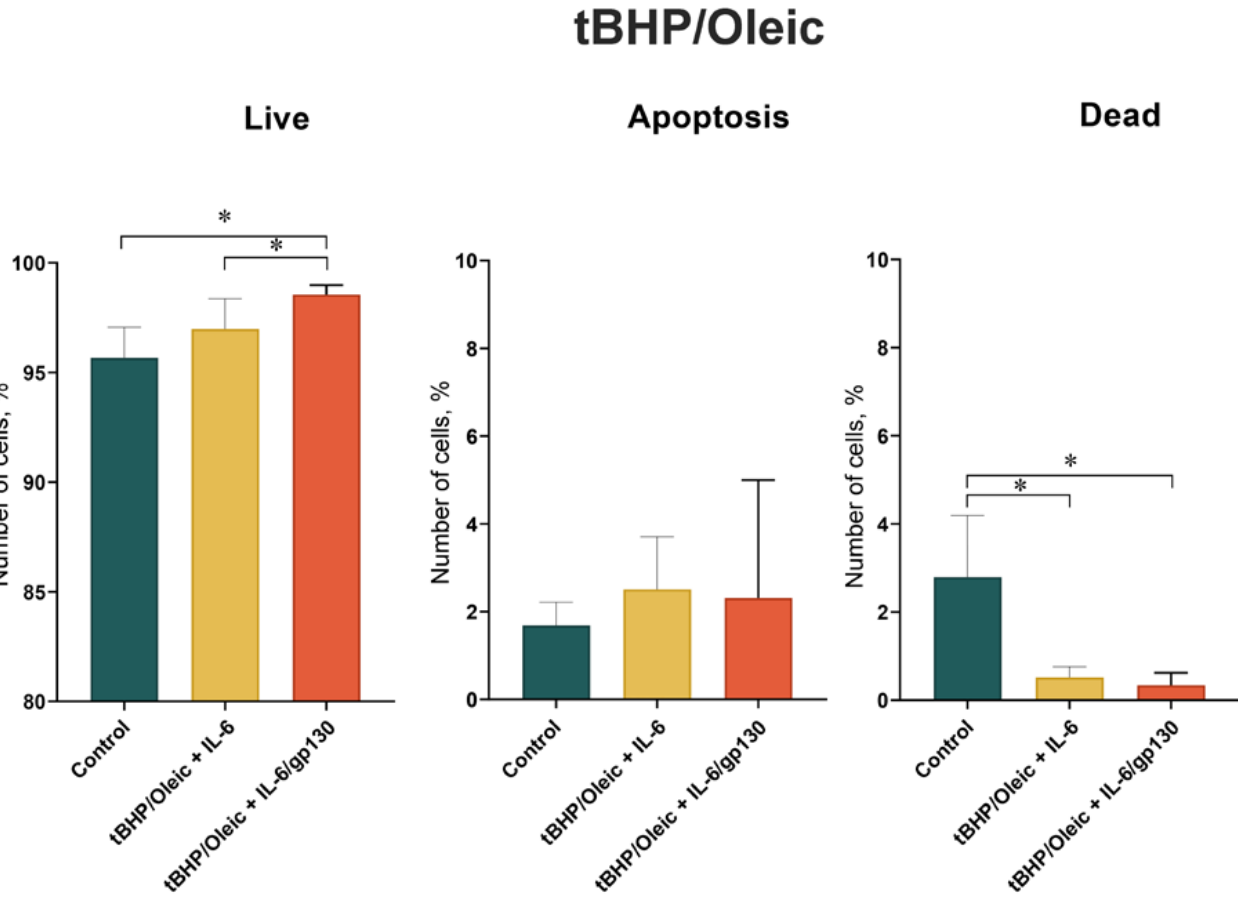
Figure 1. Percentage of live, dead, and apoptotic cells in HepG2 cultures with tBHP/Oleic; Mean ± SD; *— p < 0.05.